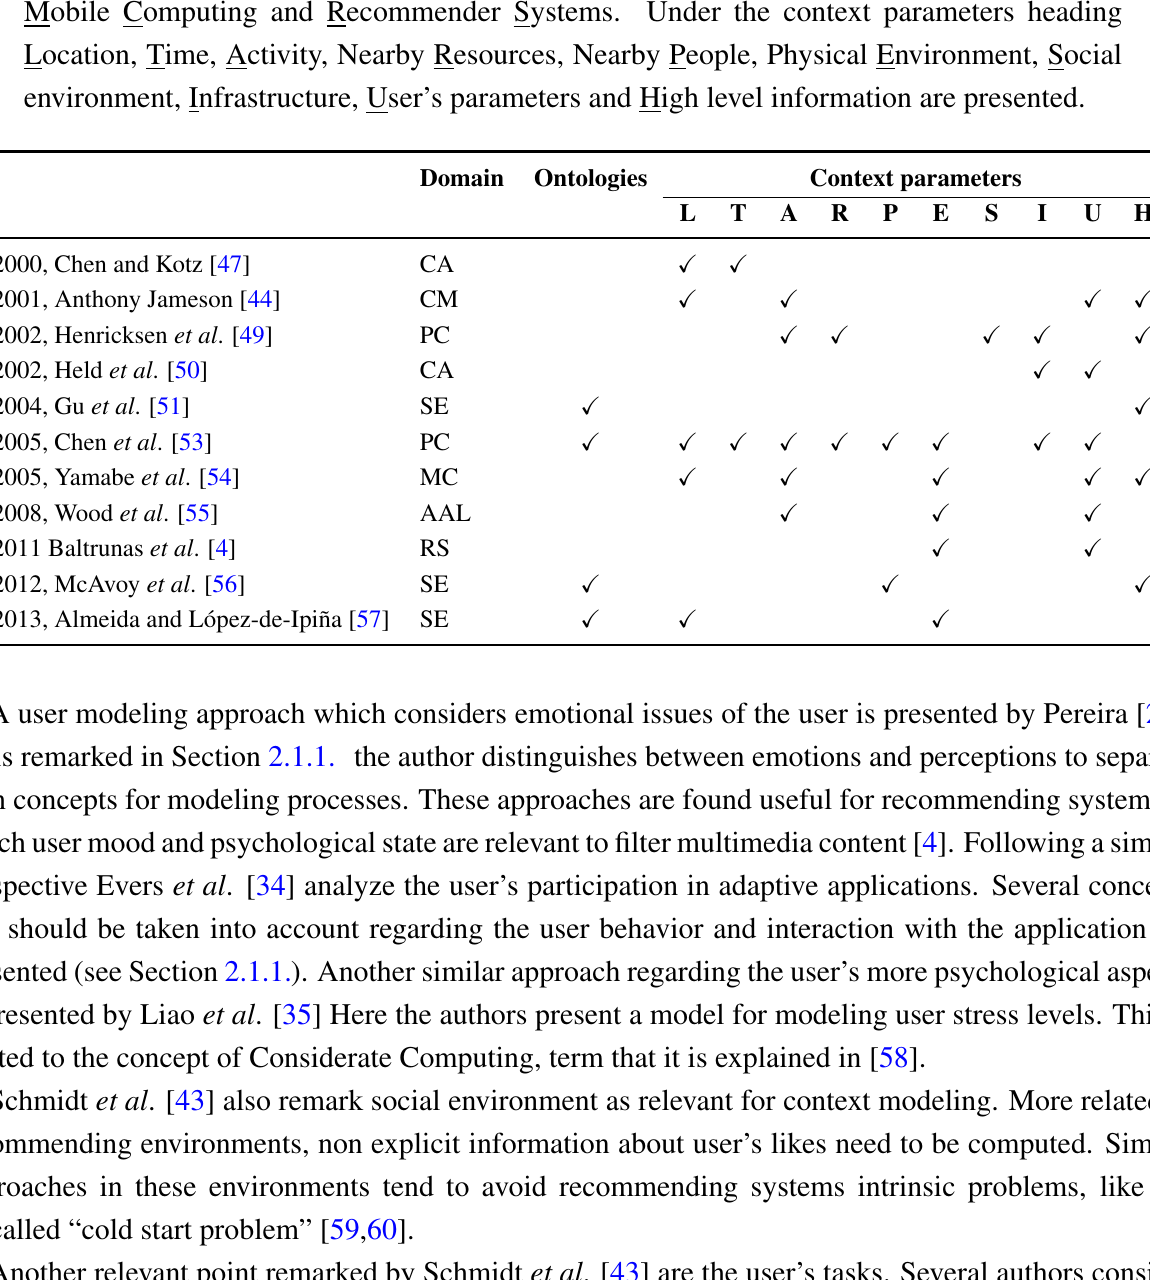
Table 2. Related work for context modeling